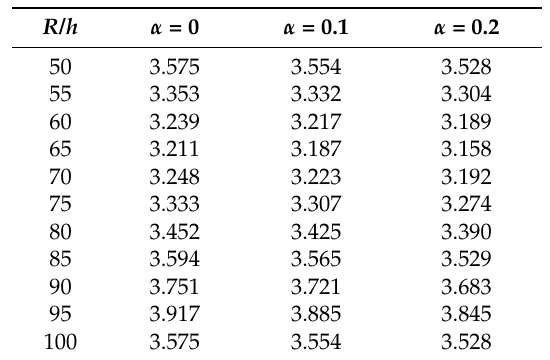
Table 9. Variation of natural frequency ω (GHz) against the radius-to-thickness ratio R/h for different porosity volume fractions of FGPM-I nanoshell ( n = 3, L = 300 h , N =